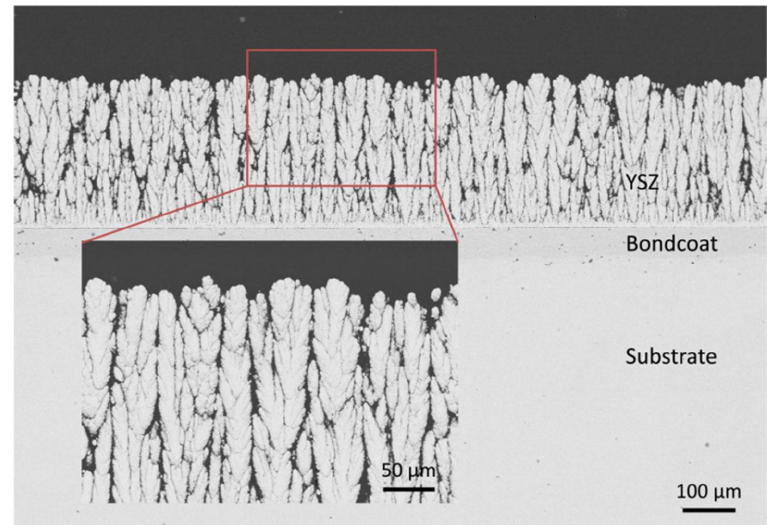
Figure 16. Cross-sectional SEM images of a YSZ thermal barrier coating fabricated by PS-PVD [77].